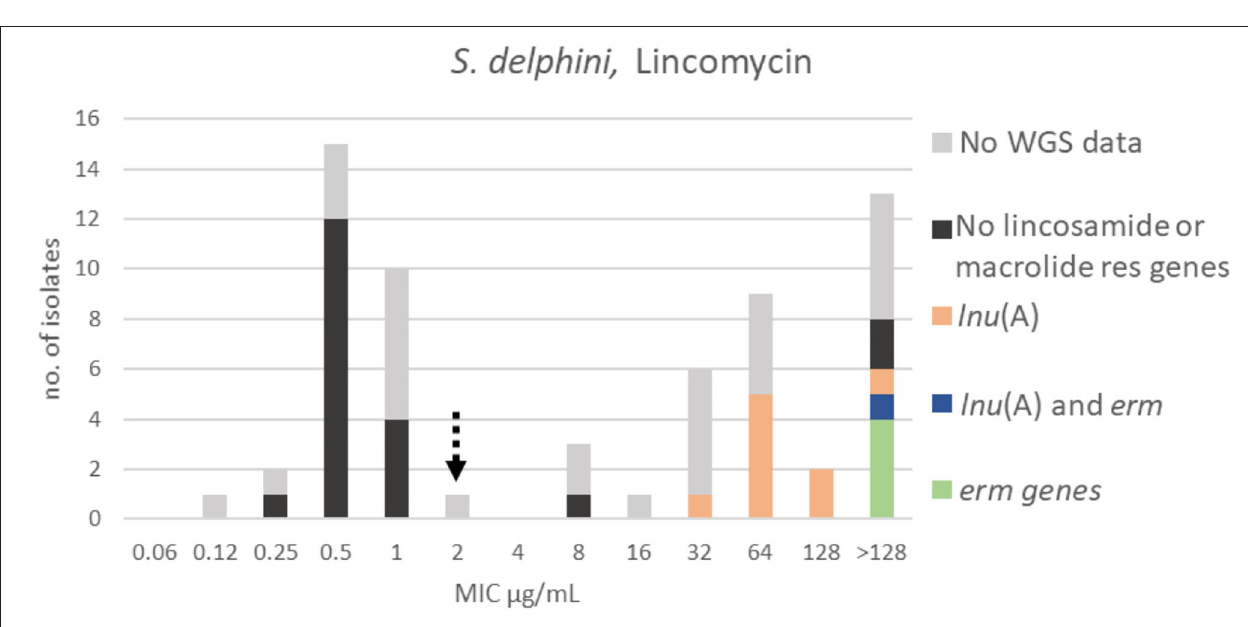
FIGURE 11 | MIC distribution of Staphylococcus delphini ( n = 63) against lincomycin in the test range of 0.06–128 µ g/mL. The broken arrow indicates the tentative epidemiological cut-off value (TECOFF). Colors indicate if the isolates have been sequenced and whether they harbor known relevant resistance genes. WGS, whole-genome sequencing; res,